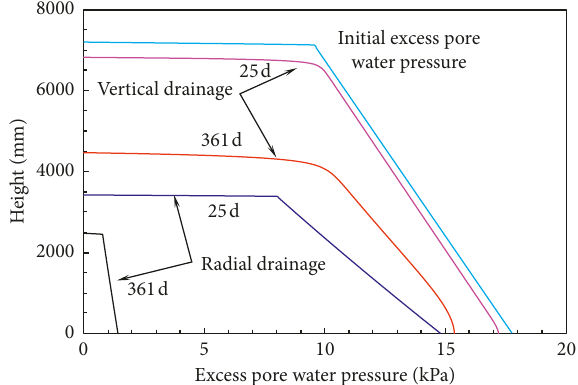
Figure 9: Curve of excess pore water pressure along soil height under different consolidation